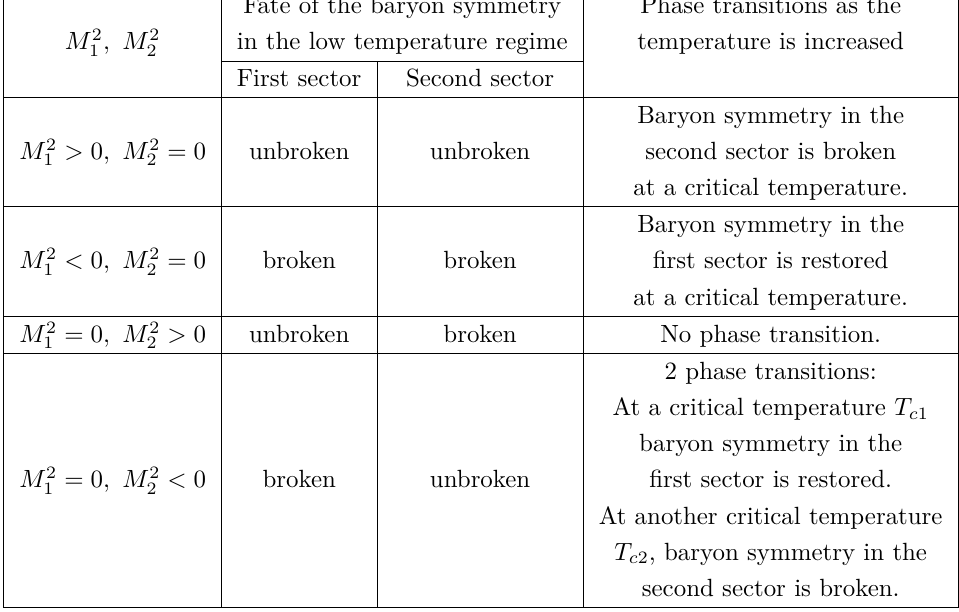
Table 1. Phase transitions for the systems in which the baryon symmetry in the first sector is unbroken and the baryon symmetry in the second sector is broken at the high temperature